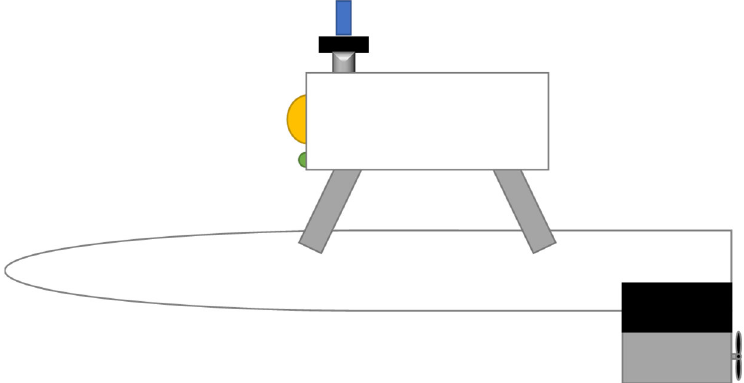
Figure 3. USV envisioned design drawing.